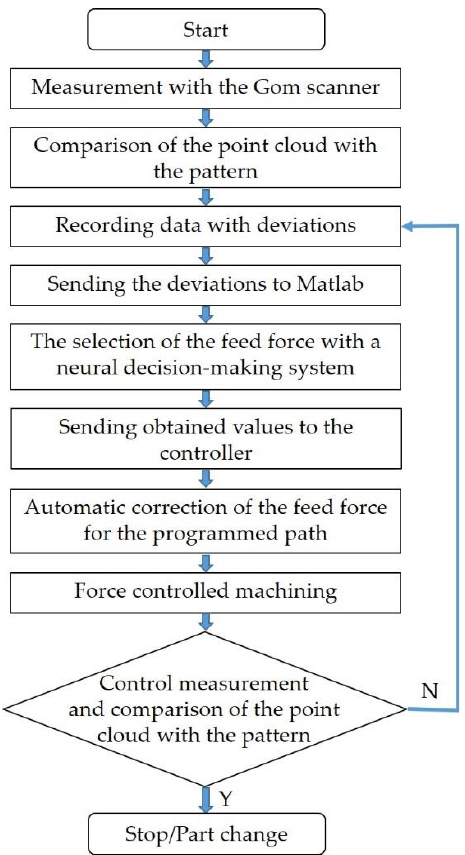
Figure 15. Application view in RobotStudio.